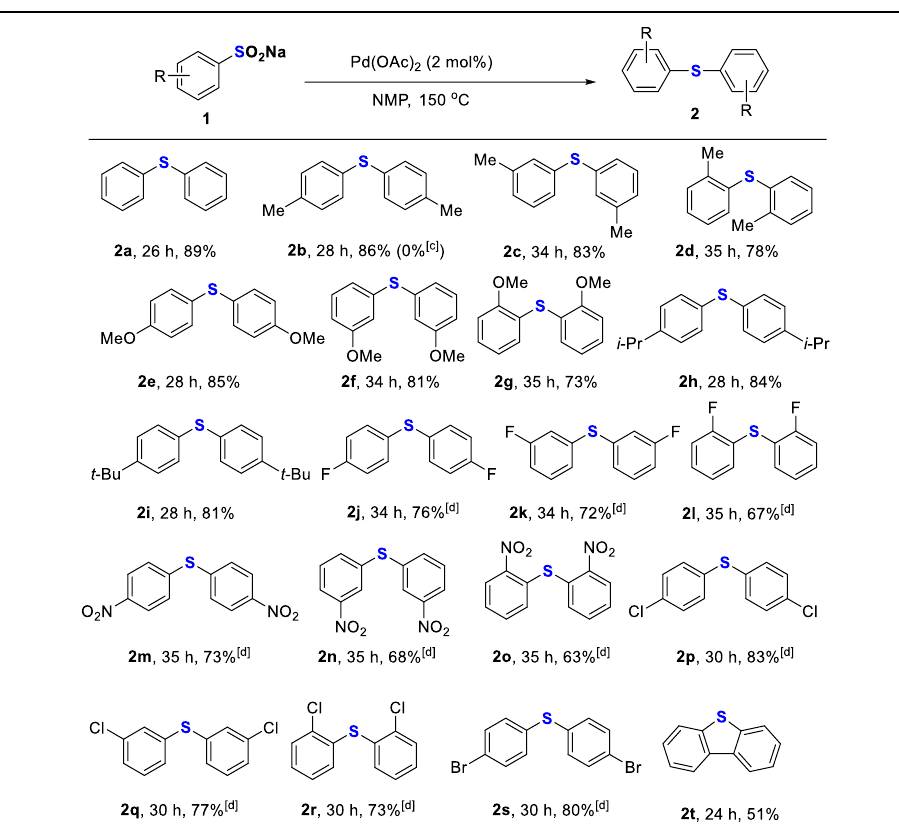
Table 2. Scope of sodium arylsulfinates to diaryl sulfides [a,b] .